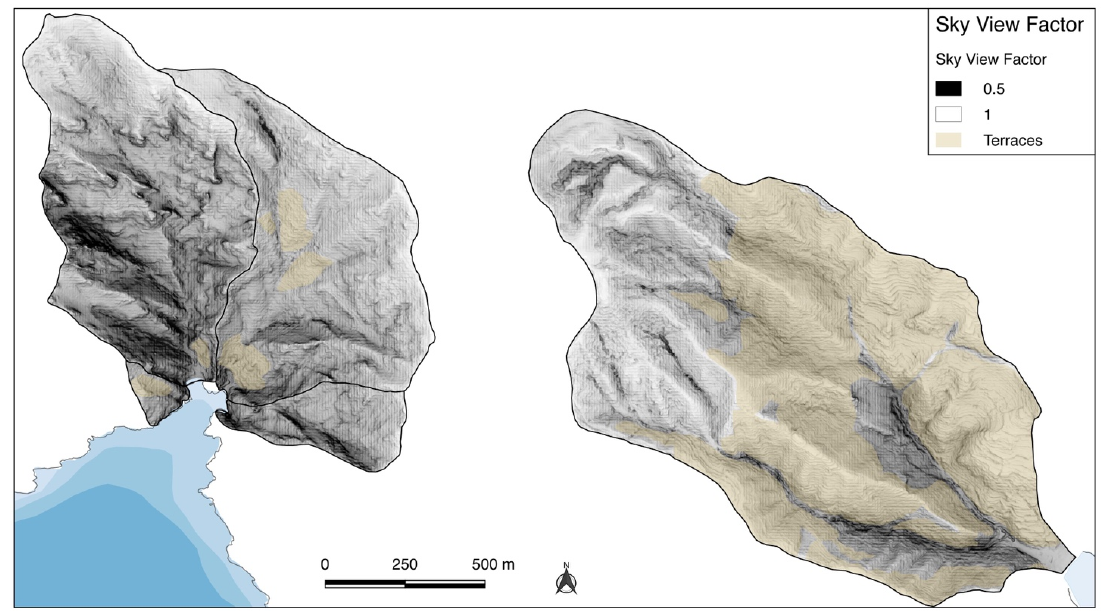
Figure 5. A detail of the studied catchments, the dotted box of Figure 2. ( A ) terrace identification on orthophotography. ( B ) in light green terrace identification with LUC method.